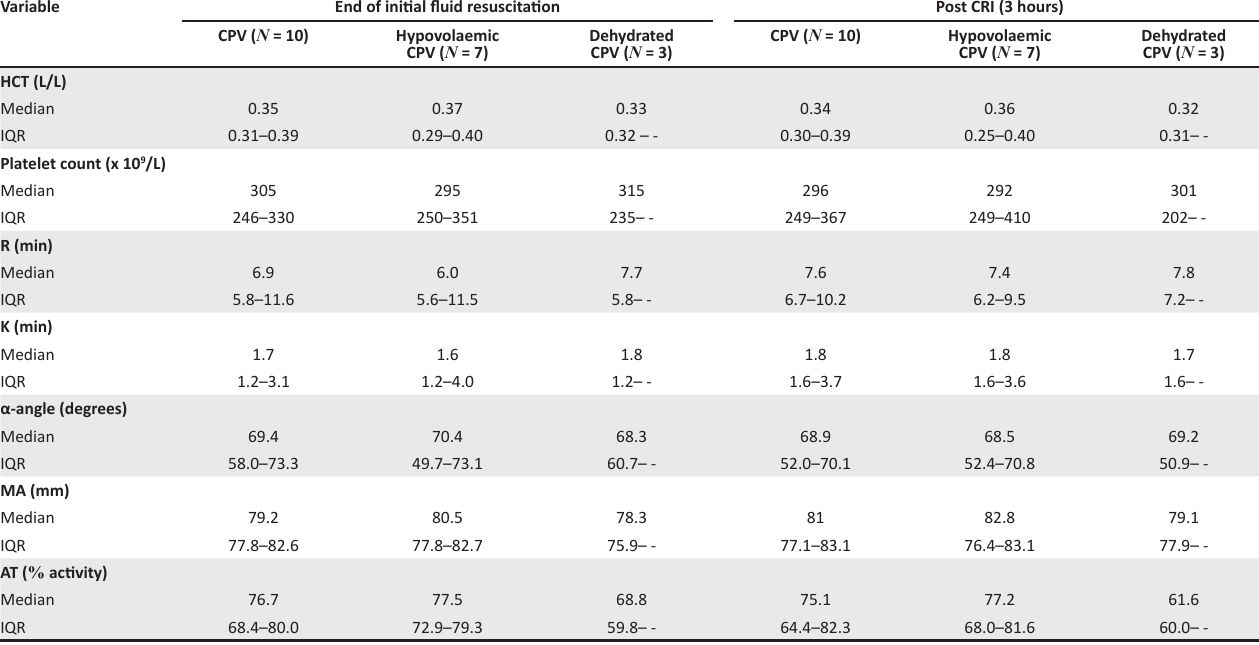
TABLE 3: Haemostatic and inflammatory variables in the 10 canine parvovirus dogs at the end of the initial fluid resuscitation and after 3 h of a lactated ringer solution constant rate infusion. No significant differences were found between canine parvovirus groups or subgroups at fluid resuscitation or after 3 h of a lactated ringer solution constant rate